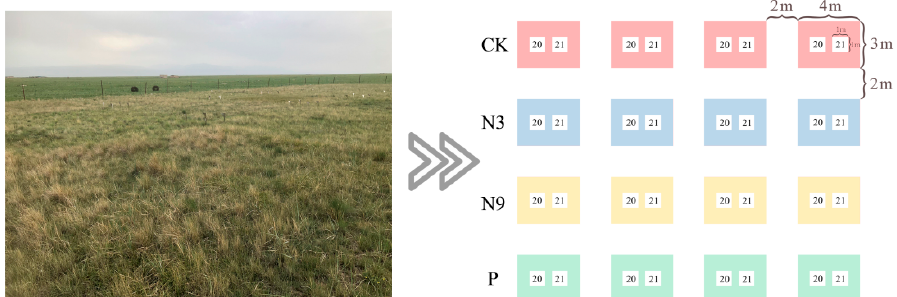
Figure 2. Plot layout. In the figure, 20 is the survey quadrat in 2020, and 21 is the survey quadrat in 2021.